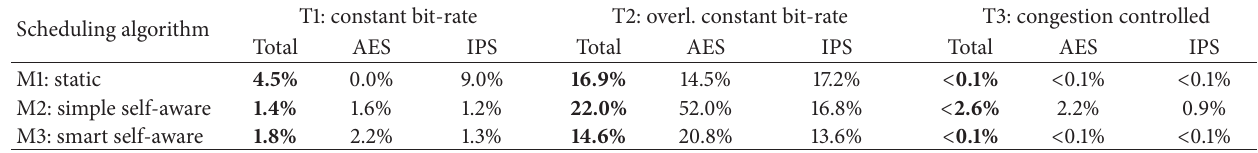
Table 2: Measured packet loss for all combinations of mapping algorithms and network traffic mixes. Scheduling algorithm